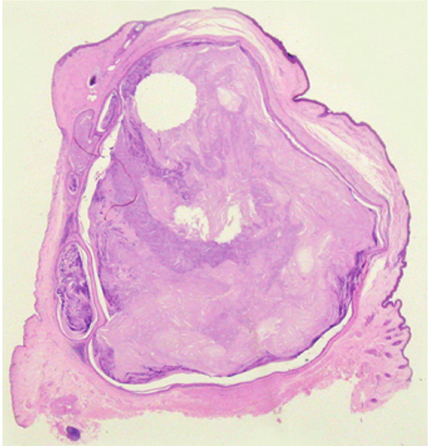
Figure 3: Whole mount photograph of lesion shown in Figure 1. Eyelid cyst filled with homogenous keratin.